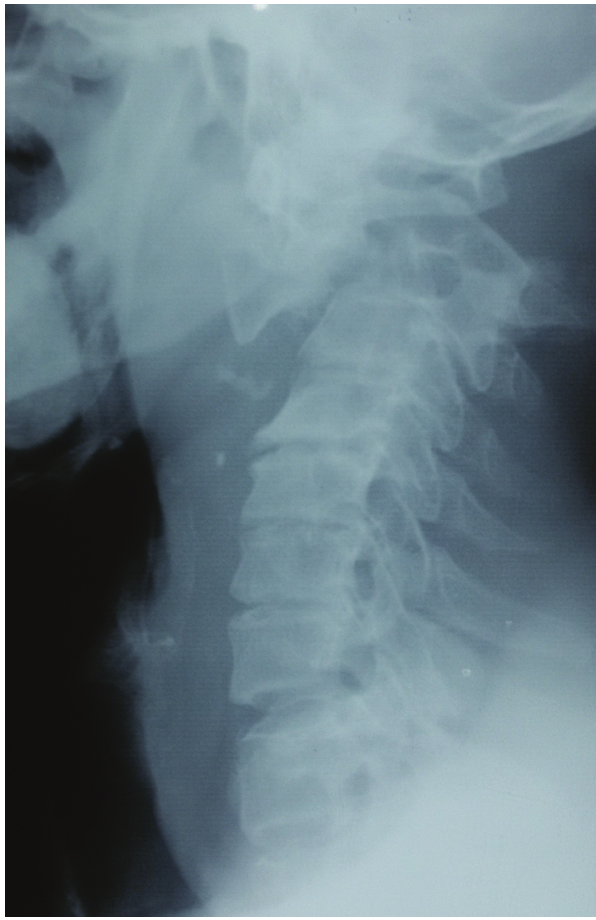
Figure 1. X-ray of the cervical spine showing Hangman’s fracture with significant translation and angulation.